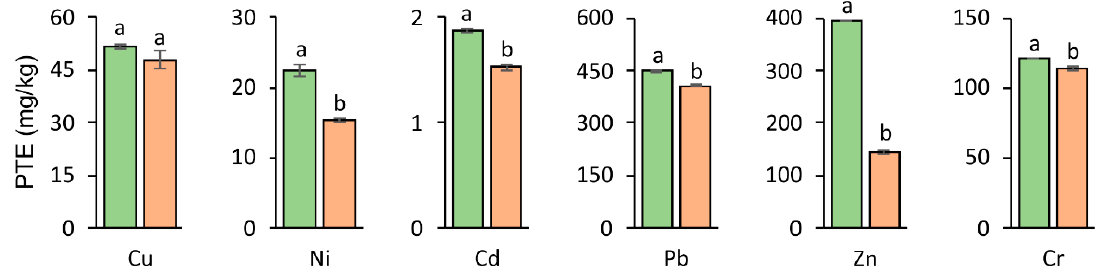
Figure 4. PTEs’ accumulation in aboveground biomass ( ■ Control ■ nZVI). For a given PTE, different letters indicate significant differences in PTE concentration in aboveground biomass between control soil and nZVI-amended soil.